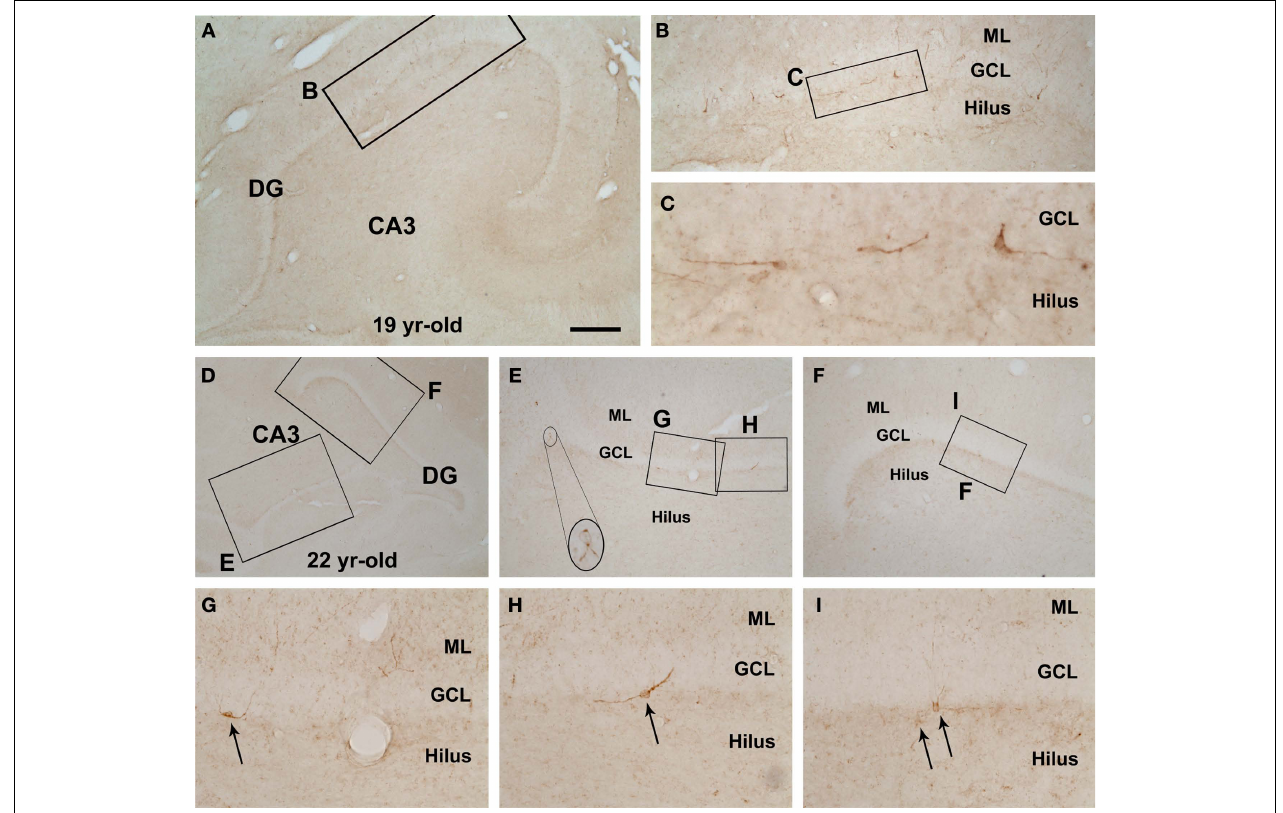
FIGURE 1 | Rare doublecortin-immunoreactive (DBX + ) cells in the hippocampal dentate gyrus (DG) of rhesus monkeys aged around 20 years old (mid-age group). Shown are low magnifi cation views of the DG and CA3 sector in a 19-year-old (A,B) and a 22-year-old (D–I) animals, with enlarged areas depicting examples of apparently dysmorphic DCX + cells at the border between